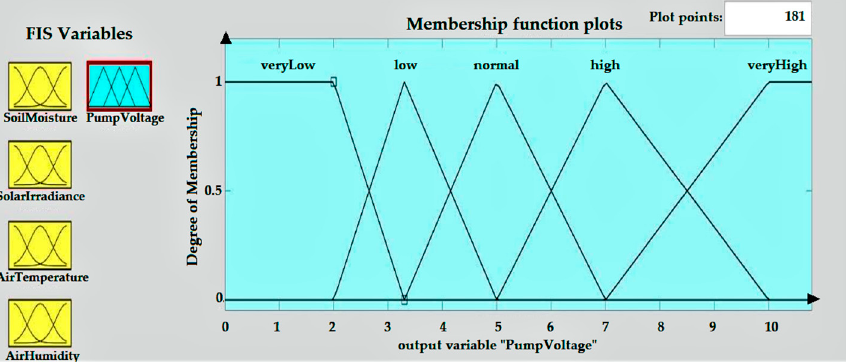
Figure 7. Pump voltage membership function